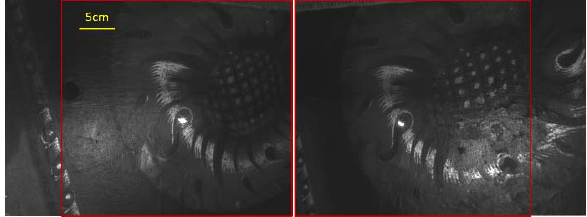
Figure 5. Images from left and right cameras with 9mm lenses, showing the region of overlap of 31x31 cm. The laser beams appear as a bright spot near centre.